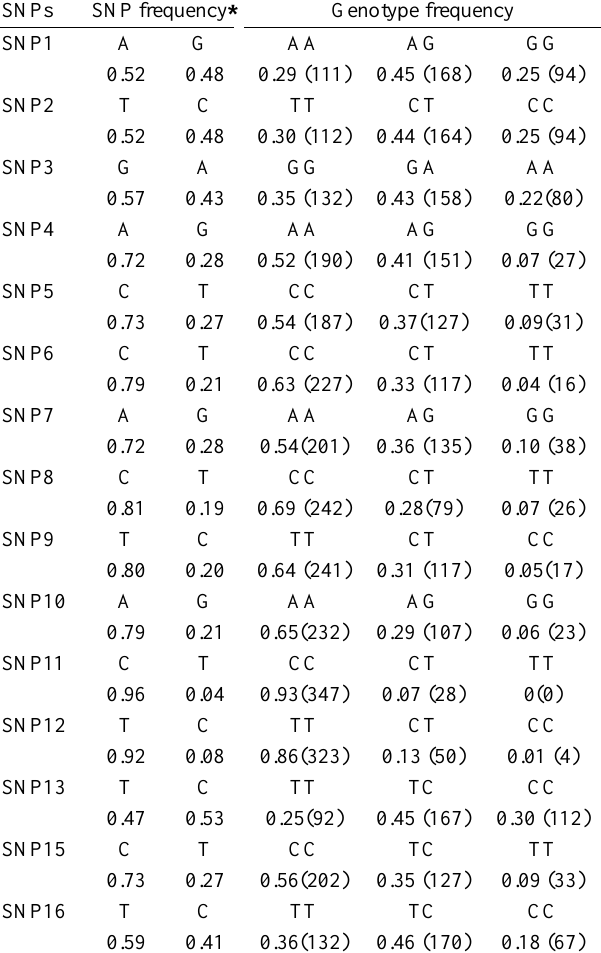
Table 3. Frequencies of alleles and genotypes of the 16 SNPs in the 14 cattle